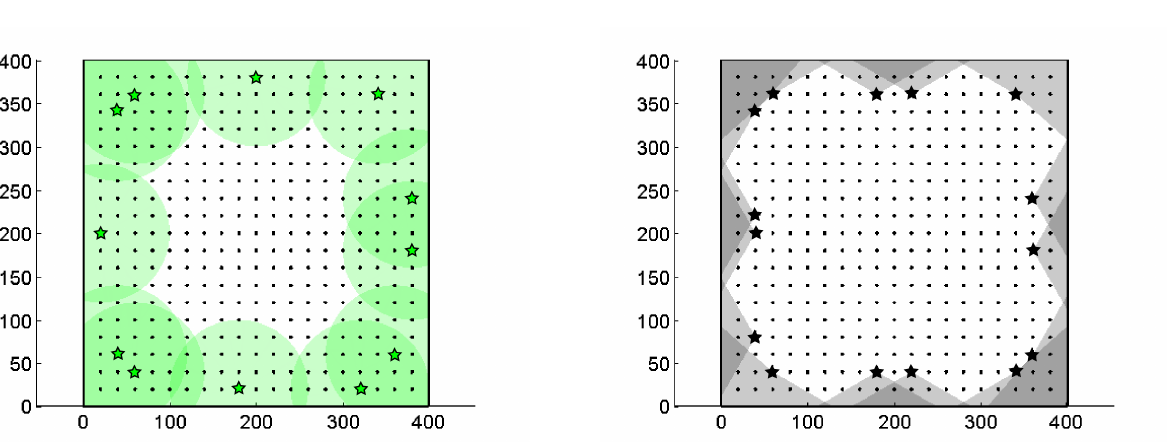
(d) At least fifteen view points are required to cover all the edges un- der range and incidence angles constraints. The visibility polygons are represented as the gray areas.